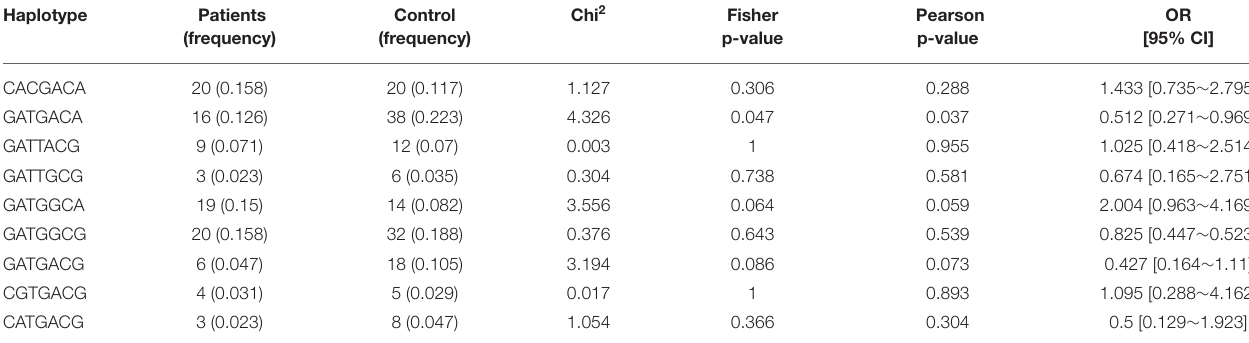
TABLE 5 | Comparison of haplotypes in gene SFTPB .